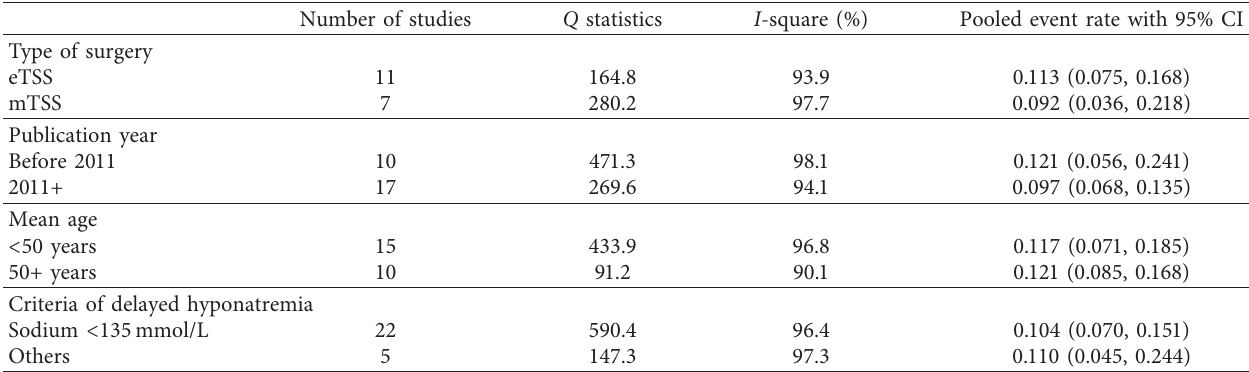
Figure 2: Main results of meta-analysis: incidence and hospital readmissions. The values of individual studies and pooled estimates of (a) overall incidence of delayed hyponatremia, (b) incidence of symptomatic delayed hyponatremia, and (c) rate of hospital readmission within 30-day postoperatively due to delayed hyponatremia are shown. A random-effects model was adopted based on the results from the heterogeneity test. Table 3: Stratified meta-analysis of the incidence of delayed hyponatremia.